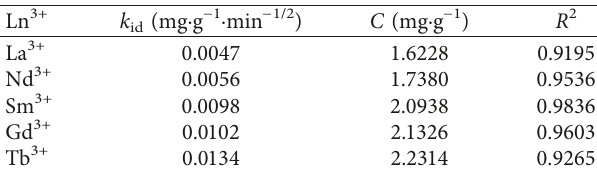
Table 3: Intraparticle diffusion kinetic parameters for Ln 3+ sorption.